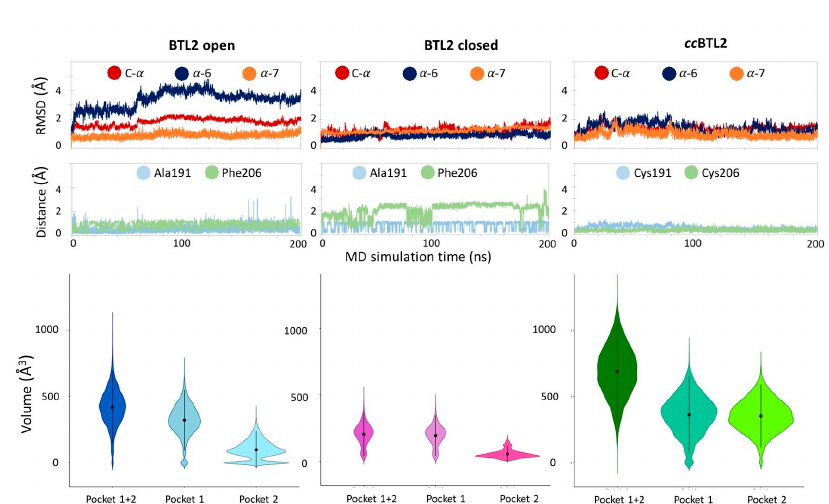
Figure 4. Analysis of the trajectories and conformations during the closed-to-open transition of cc BTL2. ( a ) (Bottom-left) Plot showing the root-mean-square deviations (RMSD) and distance between A191 and F206, of the structure generated along the targeted molecular dynamics (TMD) from the closed / inactive conformation towards the open / active conformation. (Top) Selected structures among the ensemble of intermediate conformations obtained from the TMD. (Bottom-right) In silico models of the cc BTL2 after energy minimization. ( b ) Evolution of the RMSD of the entire C- α backbone (red), α -6 helix (blue), α -7 helix (orange), and in light blue and green the RMSD of the entire amino acid Ala191 and Phe206 and their corresponding mutant during the 200 ns MD simulation. Violin plots of pocket exposure obtained from the Mdpocket software in Å 3 ; the EGC-404 molecule from the PDB code 2W22 has taken as reference for Pocket 1, EGC403 for Pocket 2, and the summary of both for Pocket 1 + 2. Mean values and standard deviation are also plot (black dots and solid lines).